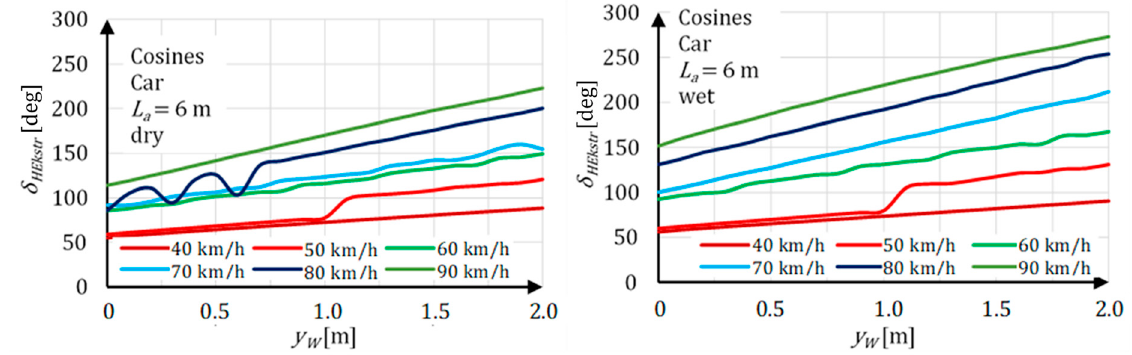
Figure 21. Extreme values of the steering wheel angle (the first extremum of the δ H ( x ) curve) vs. the clearance margin y W for vehicle speeds of v = 40–90 km/h.